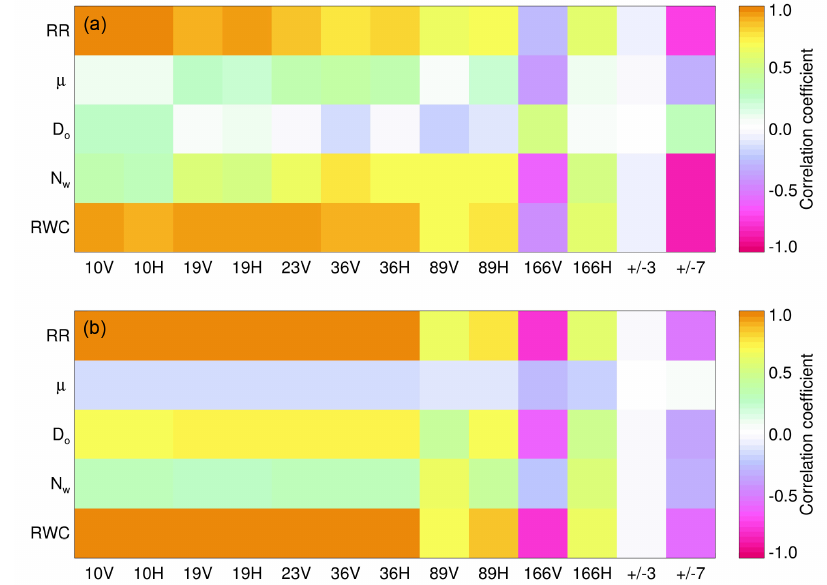
Figure 4. Correlations of T B at GMI frequencies with the DSD parameters (Eq. 1) as well as rain rate (RR) and RWC, as derived from